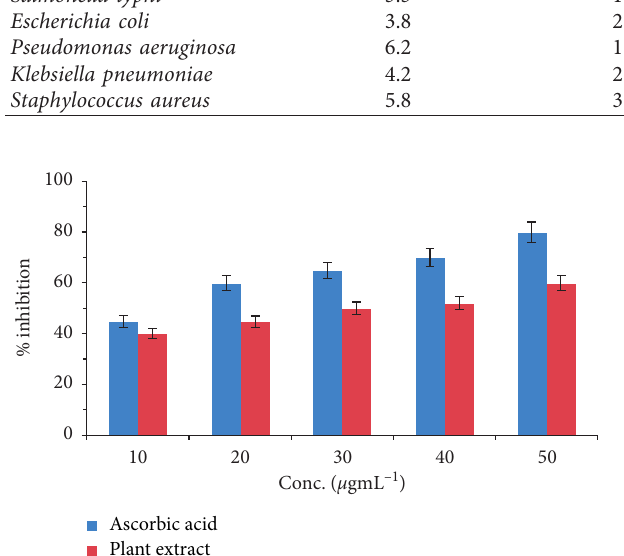
Figure 3: Results of DPPH radical scavenging potential of the R. raetam stem in comparison with ascorbic acid as